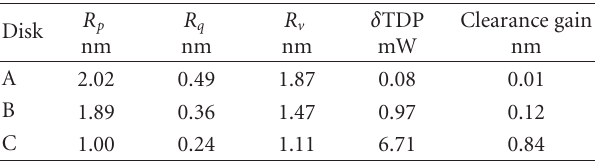
Table 2: Disk roughness parameters and its e ff ect on TDP/clearance gain.